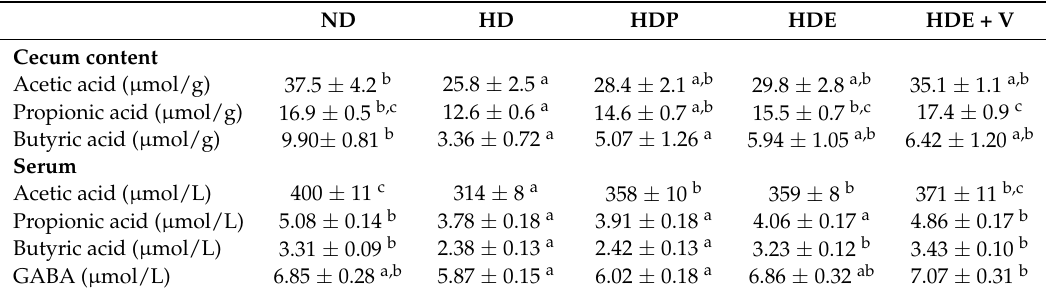
Table 7. SCFAs and GABA levels in cecum content and